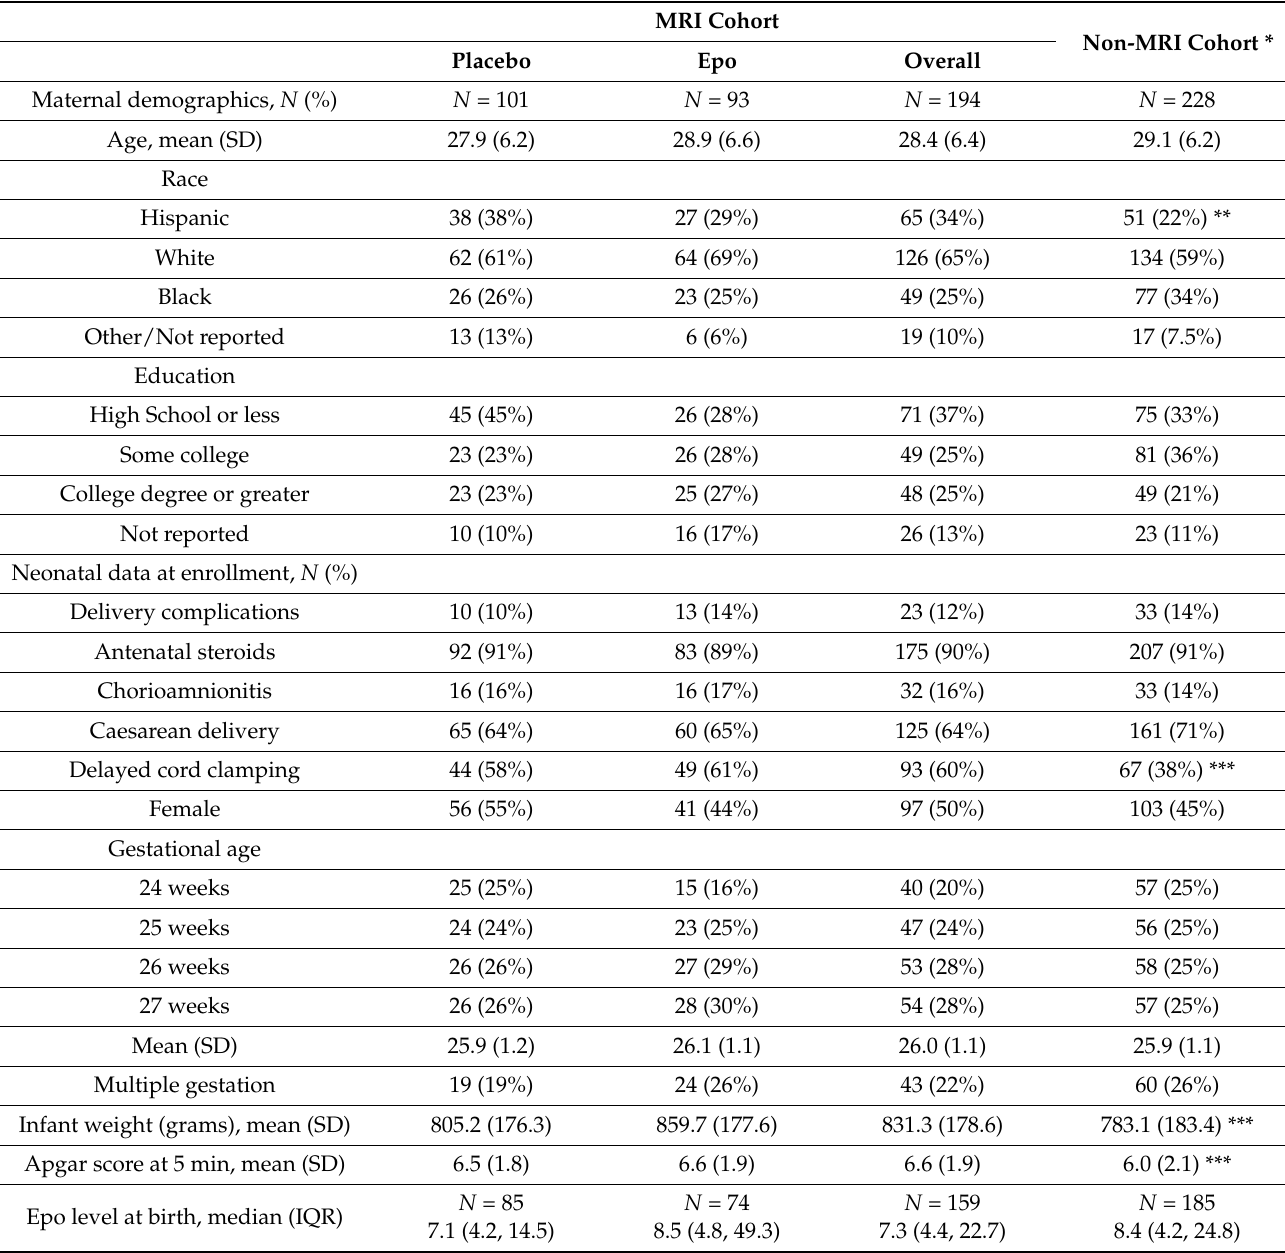
Table 1. Baseline demographics and clinical characteristics by treatment